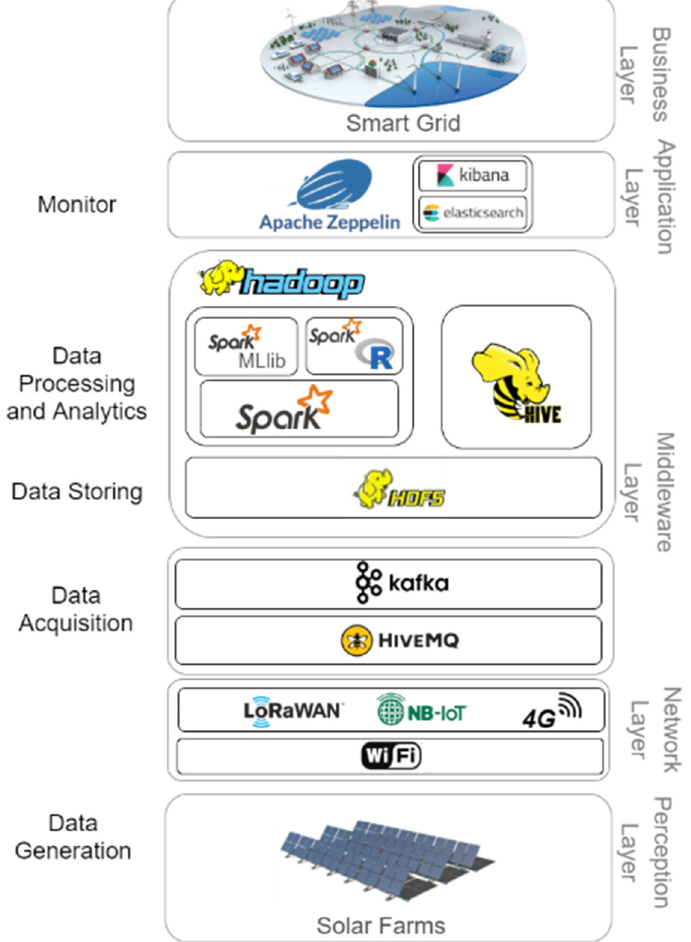
Figure 4. Software